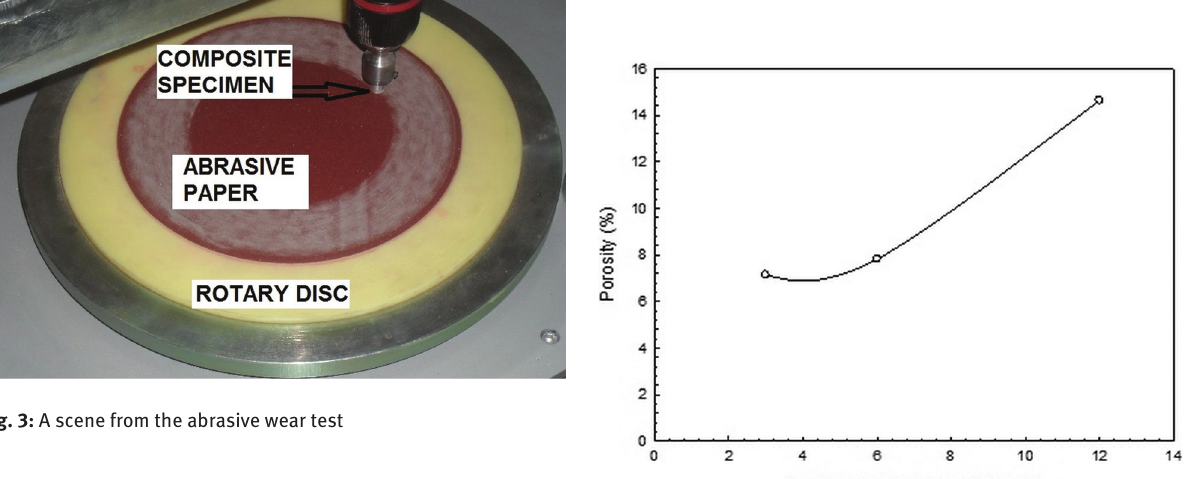
Fig. 4: Hardness values related to reinforcement volume ratio of the composites manufactured in 4 minutes at 500 rev/min stirring speed at 800 °C